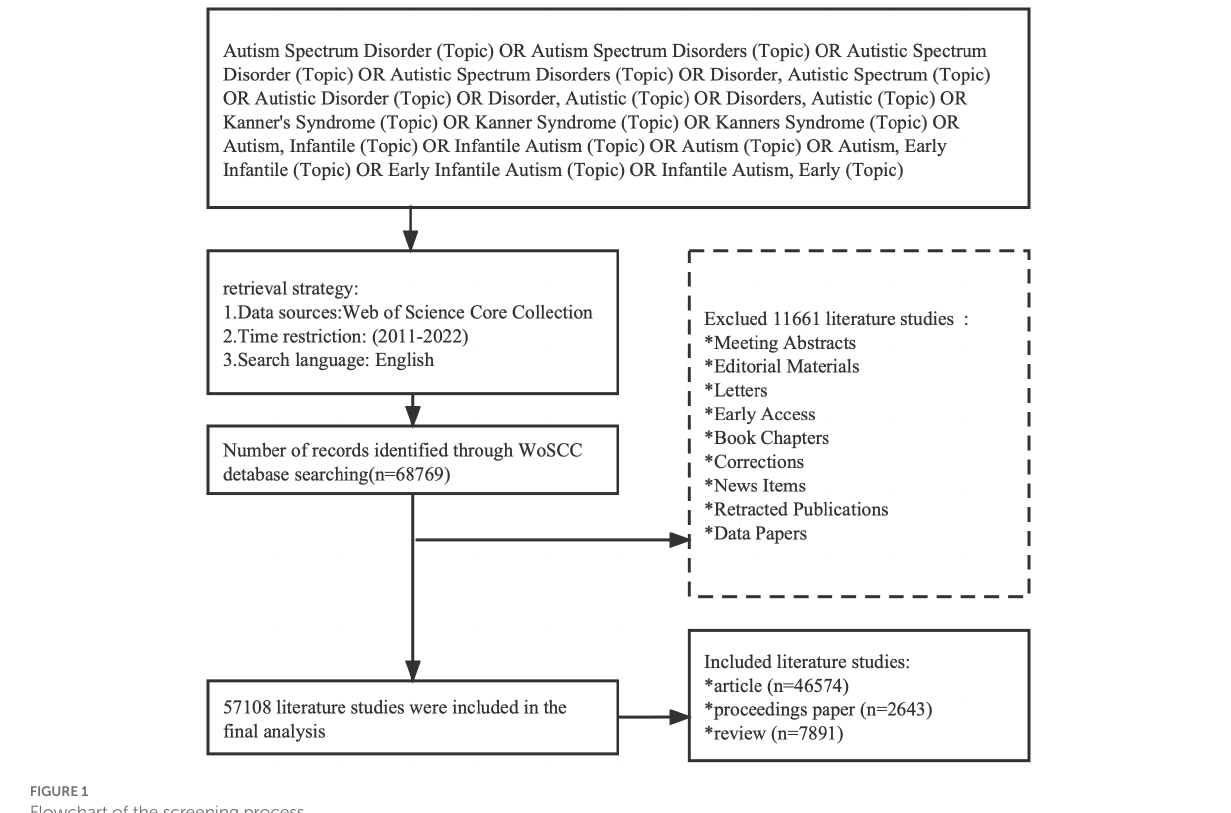
FIGURE 1 Flowchart of the screening